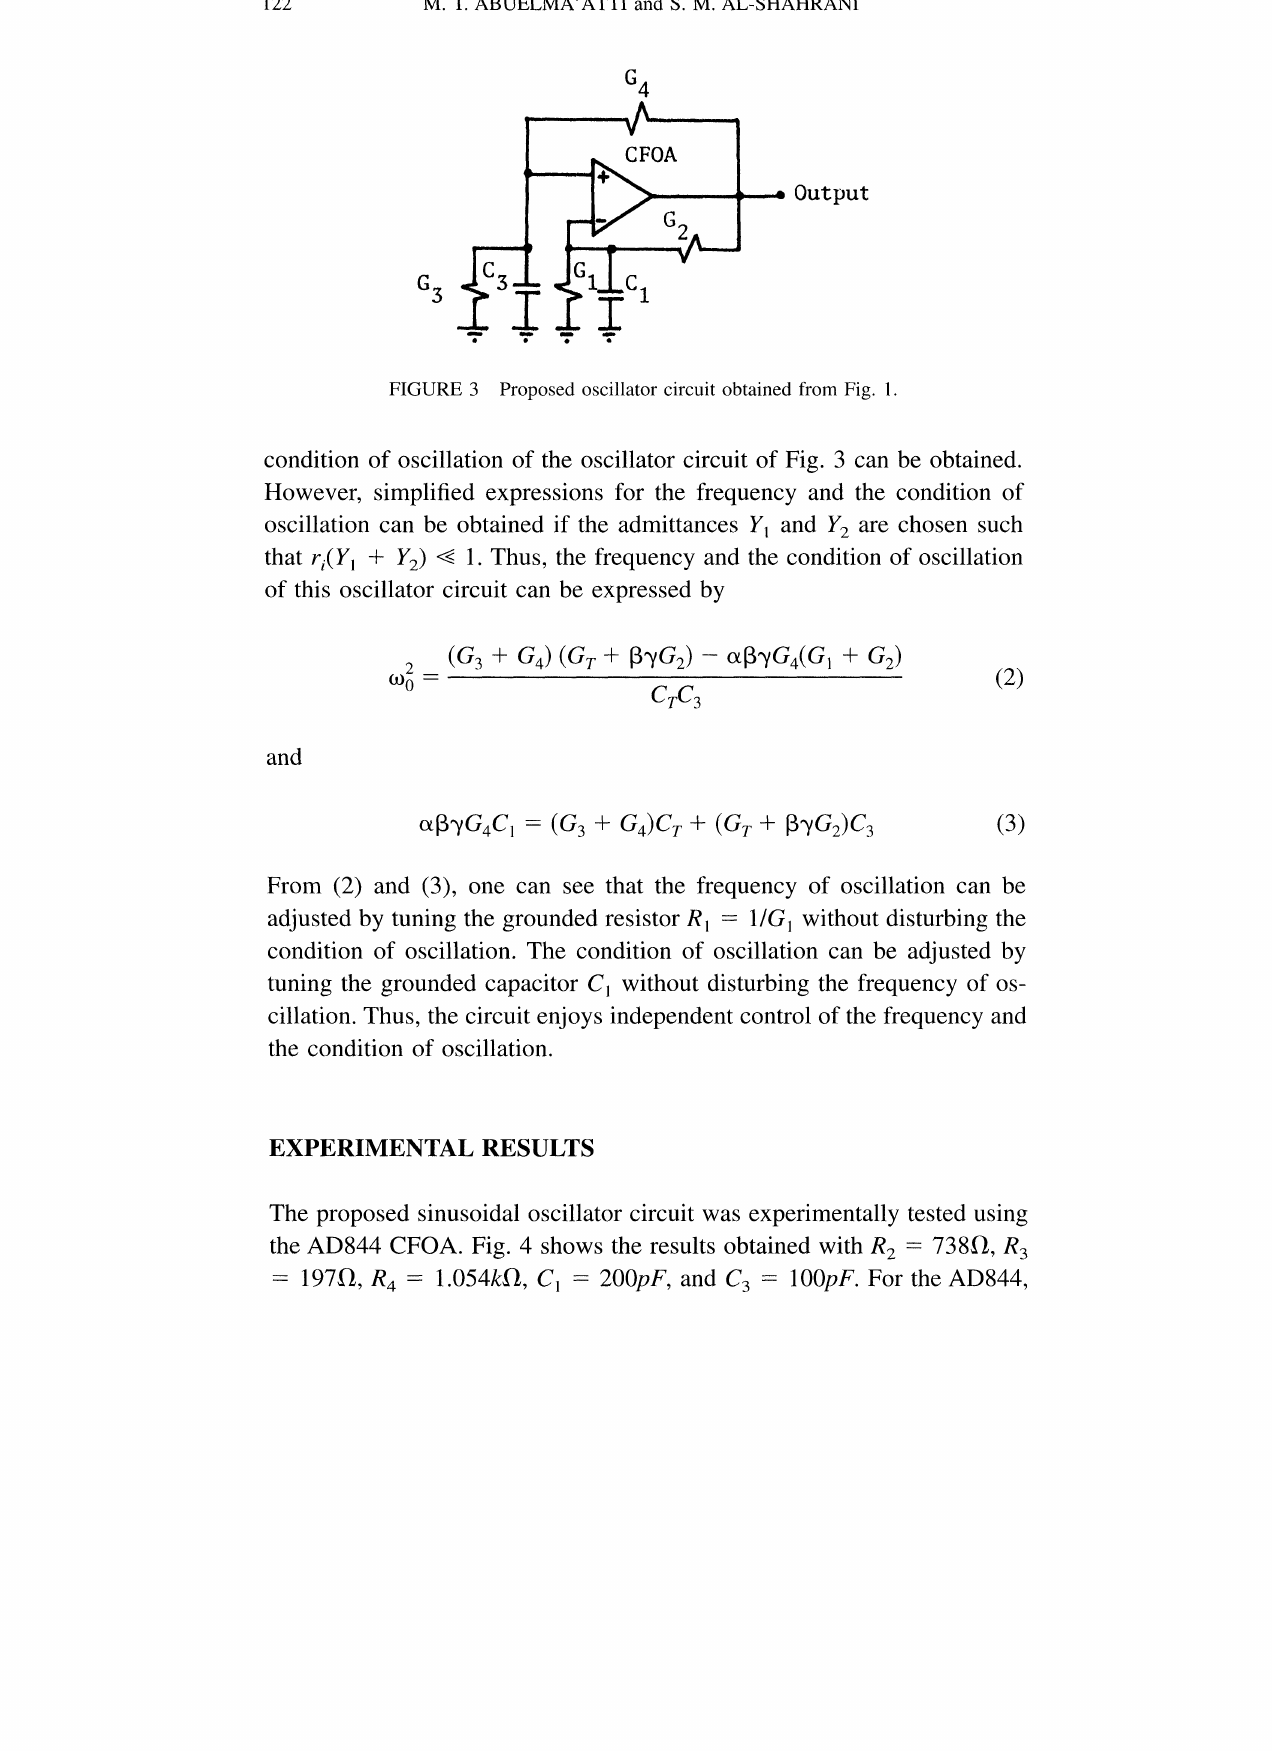
FIGURE 3 Proposed oscillator circuit obtained from Fig.